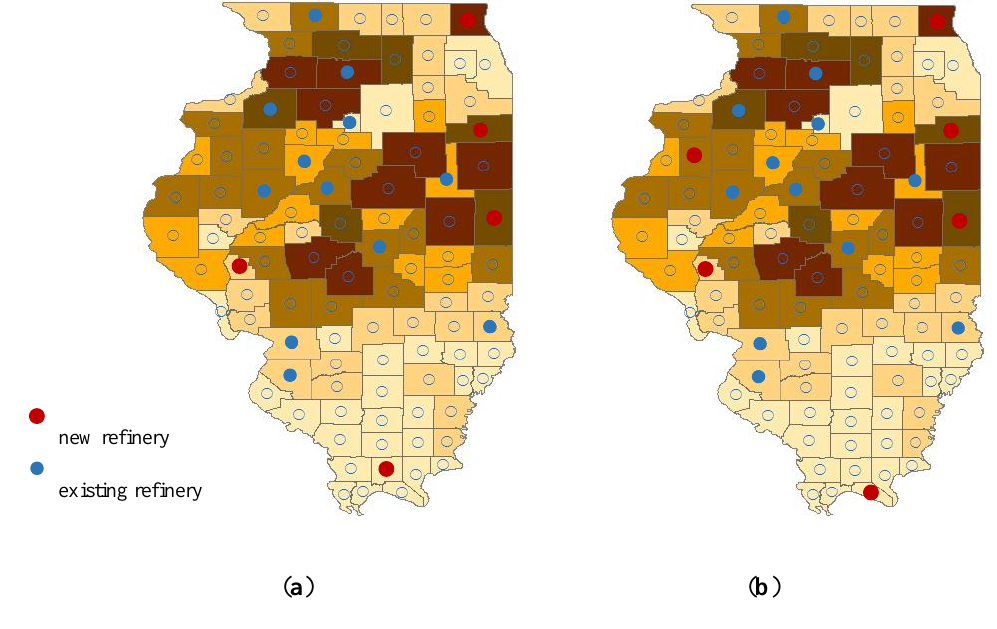
Figure 2. Optimal refinery locations from the deterministic and reliable models. ( a ) deterministic model; ( b ) reliable